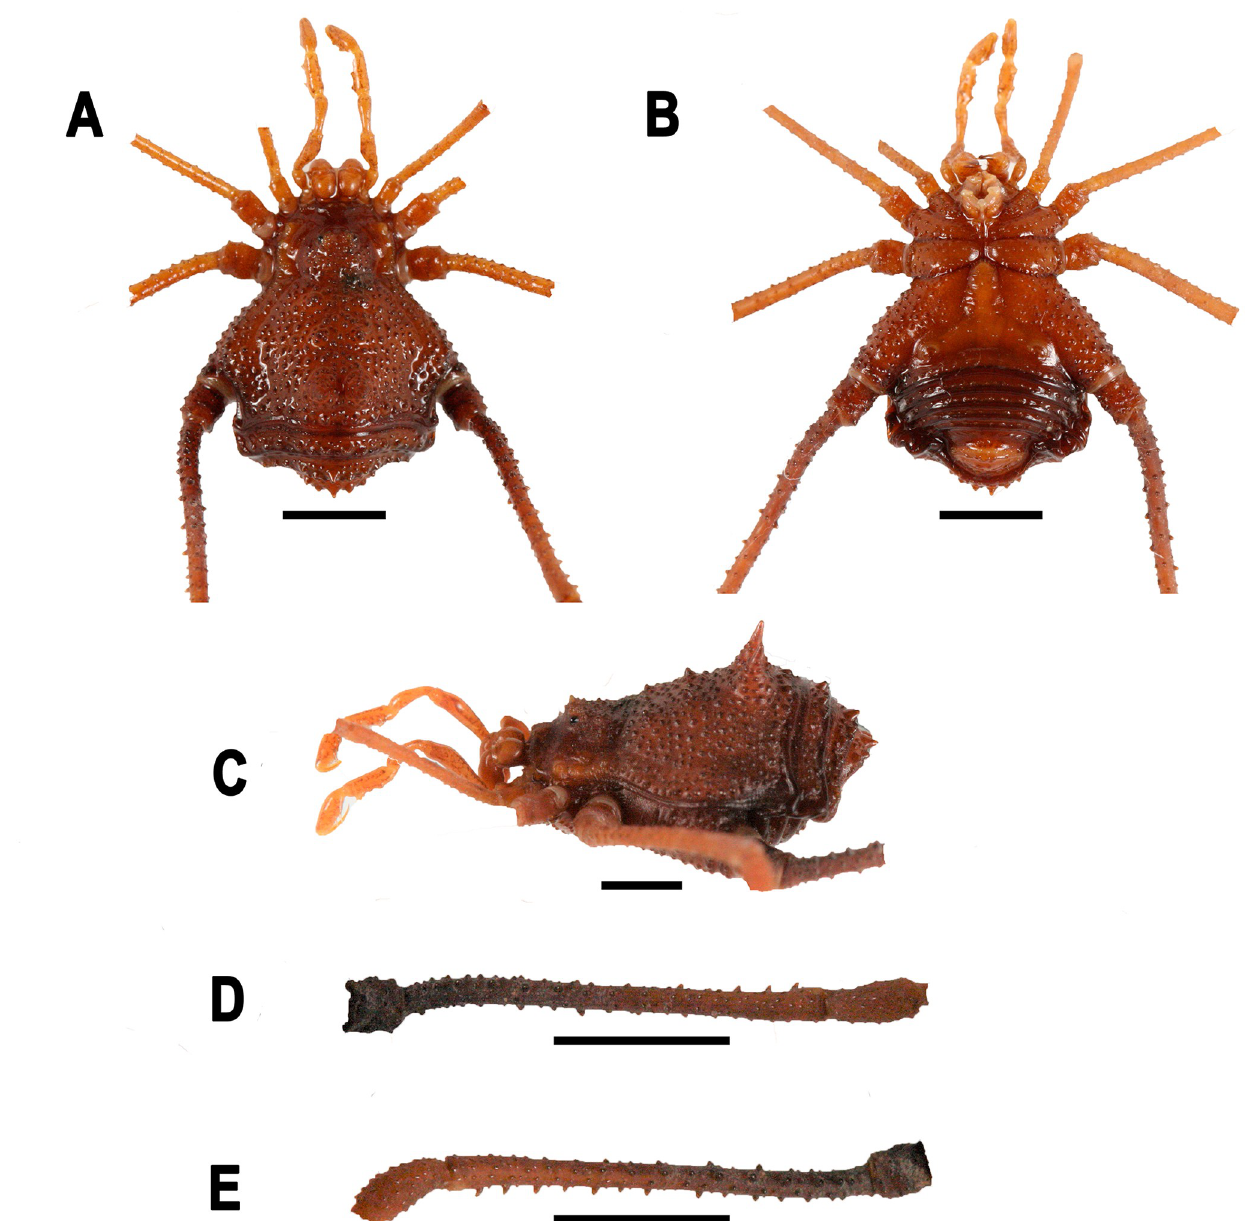
Fig 5. Neosadocus bufo ( “Bunoweyhia” variabilis female paralectotype, MNRJ 41803). A. Dorsal view. B. Ventral view. C. Left lateral view. D–E. Right trochanter–patella IV (D: retrolateral view; E: prolateral view). Scale bars: 3 mm.